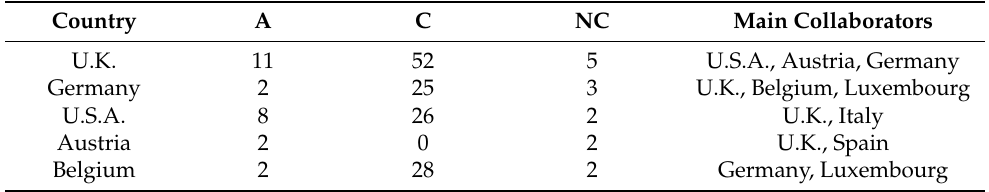
Table 14. Top 5 most cooperative countries and main collaborators in the Mathematics area.